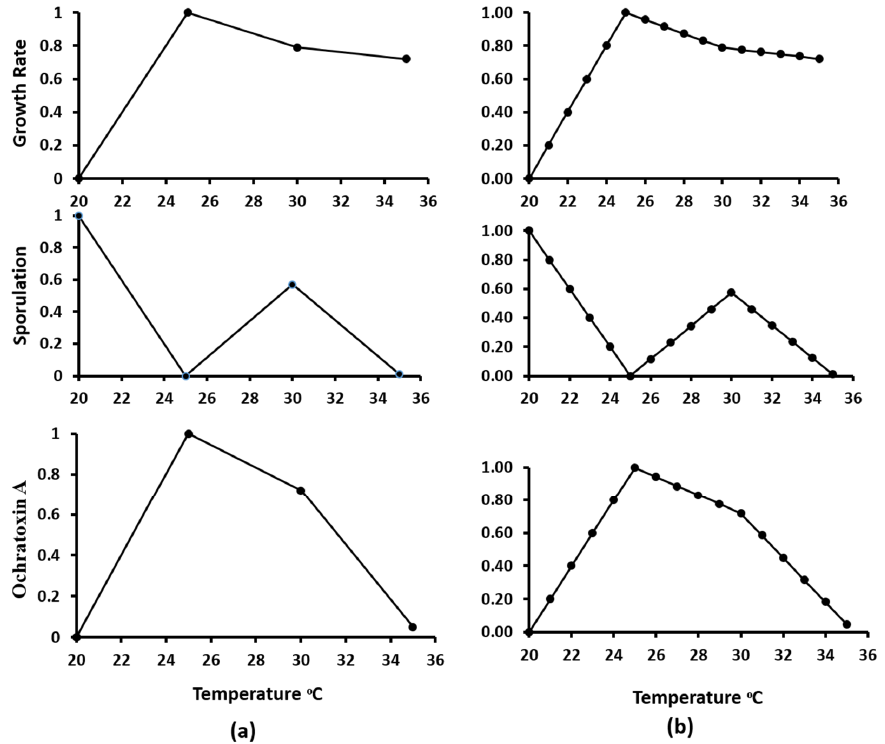
Figure 5. Growth rate, sporulation, and ochratoxin A data of A. westerdijkiae IBT 23971 before ( a ) and after ( b ) linear interpolation in relation to temperature at 0.95 a w on YES medium.